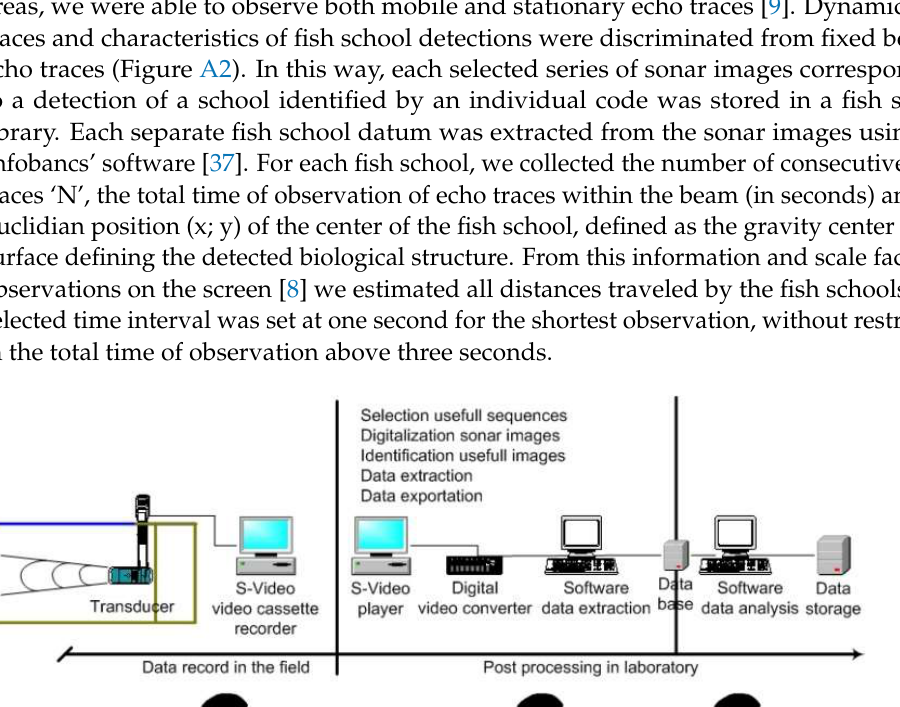
Figure A2. Diagram of the experimental set up, showing the sonar beams covering the channel, bank to bank. On the right, an example of a sonar picture where the dynamic echoes of fish school (inside the circle, in t 1 , t 2 and t 3 ) were discriminated from the fixed echoes of the bottom (Reprinted with permission from [9]). Appendix B Figure A3. Cumulative frequency of the fish school net to gross displacement ratio ‘straightness index’; the schools having a SI above 0.9 (~ 65% of the schools) were considered to exhibit an ori- ented swimming behavior that corresponds to a certain form of active migration. In white, the Ingril lagoon schools, and in black the Prevost ones. 0 20406080100 0.1 0.2 0.3 0.4 0.5 0.6 0.7 0.8 0.9